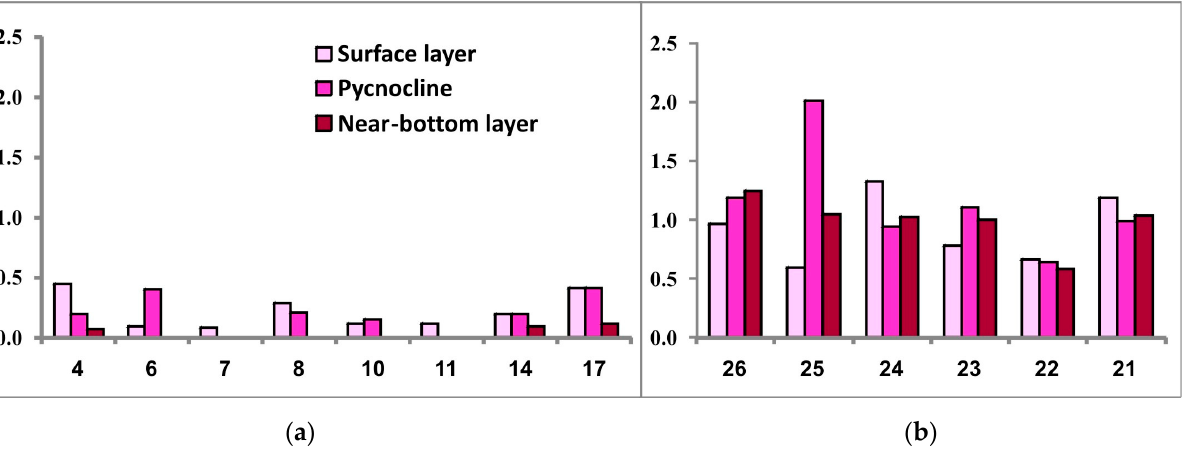
Figure 7. Chlorophyll- a concentration (µg/L) in the three investigated seawater layers at sampling stations located in the southwestern Kara Sea ( a ) and the southeastern Barents Sea ( b ). In the SEBS, due to shallow depths, chlorophyll- a was almost evenly distributed throughout the water column. Surface chlorophyll- a maximum reached 1.48 mg/m 3 (0.92 ± 0.29 mg/m 3 on average). In the pycnocline layer, chlorophyll- a concentration averaged 1.15 ± 0.46 mg/m 3 , with a maximum of 2.02 mg/m 3 . Near-bottom chlorophyll- a concentration did not exceed 1.24 mg/m 3 (0.99 ± 0.22 mg/m 3 on average). Low average chlorophyll- a concentrations in the photic layer, 0.24 ± 0.13 mg/m 3 in the SWKS and 1.02 ± 0.33 mg/m 3 in the SEBS, and the proportion of pheophytin > 50% in both regions, are typical for the late-summer and autumn stages of the seasonal succession of pelagic algal communities [45]. An assessment of photosynthetic pigments contents by the fluorescence value demon- strates a similar picture (Figure 8).